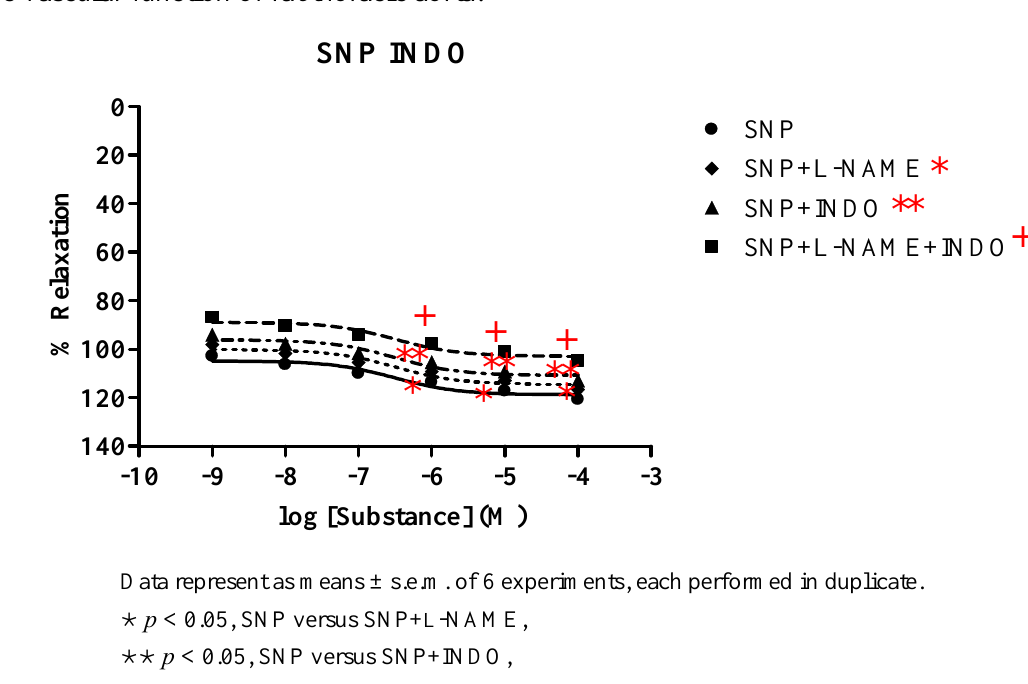
Figure 9. Effect of SNP in the presence of L -NAME, INDO and L -NAME plus INDO on the vascular function of rat thoracic aorta.